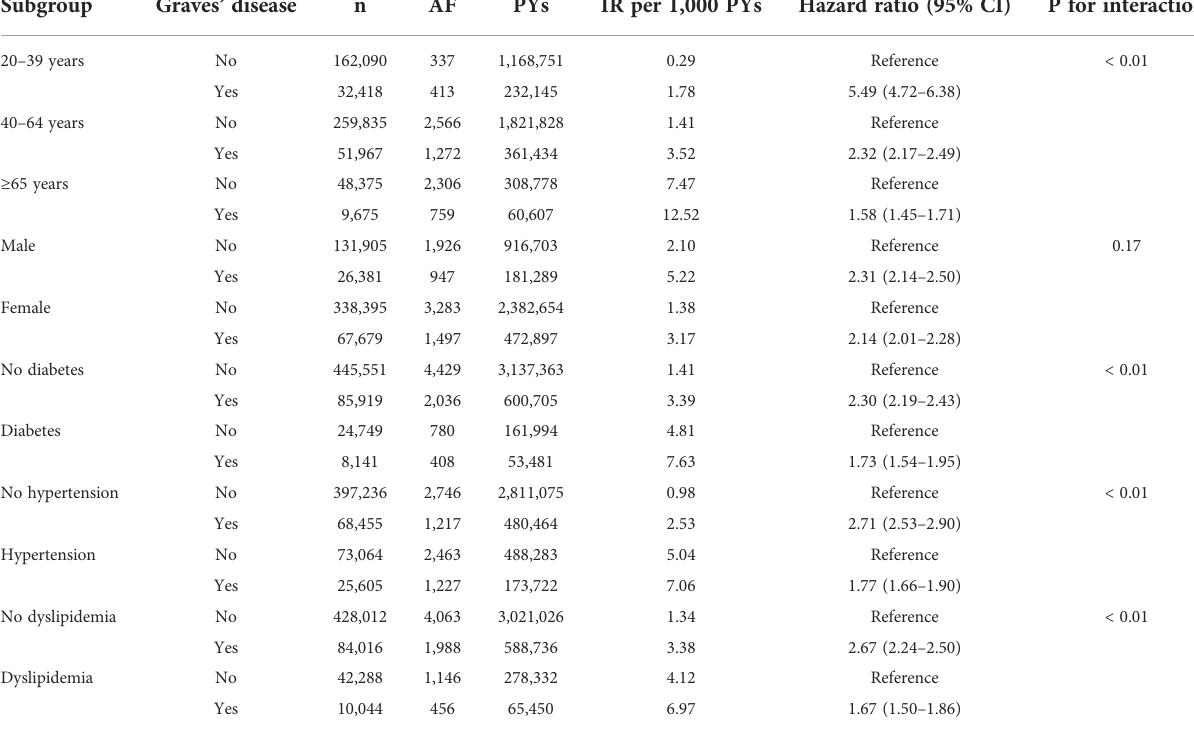
TABLE 3 Subgroup analyses of atrial fi brillation risk among patients with Graves ’ disease and controls.